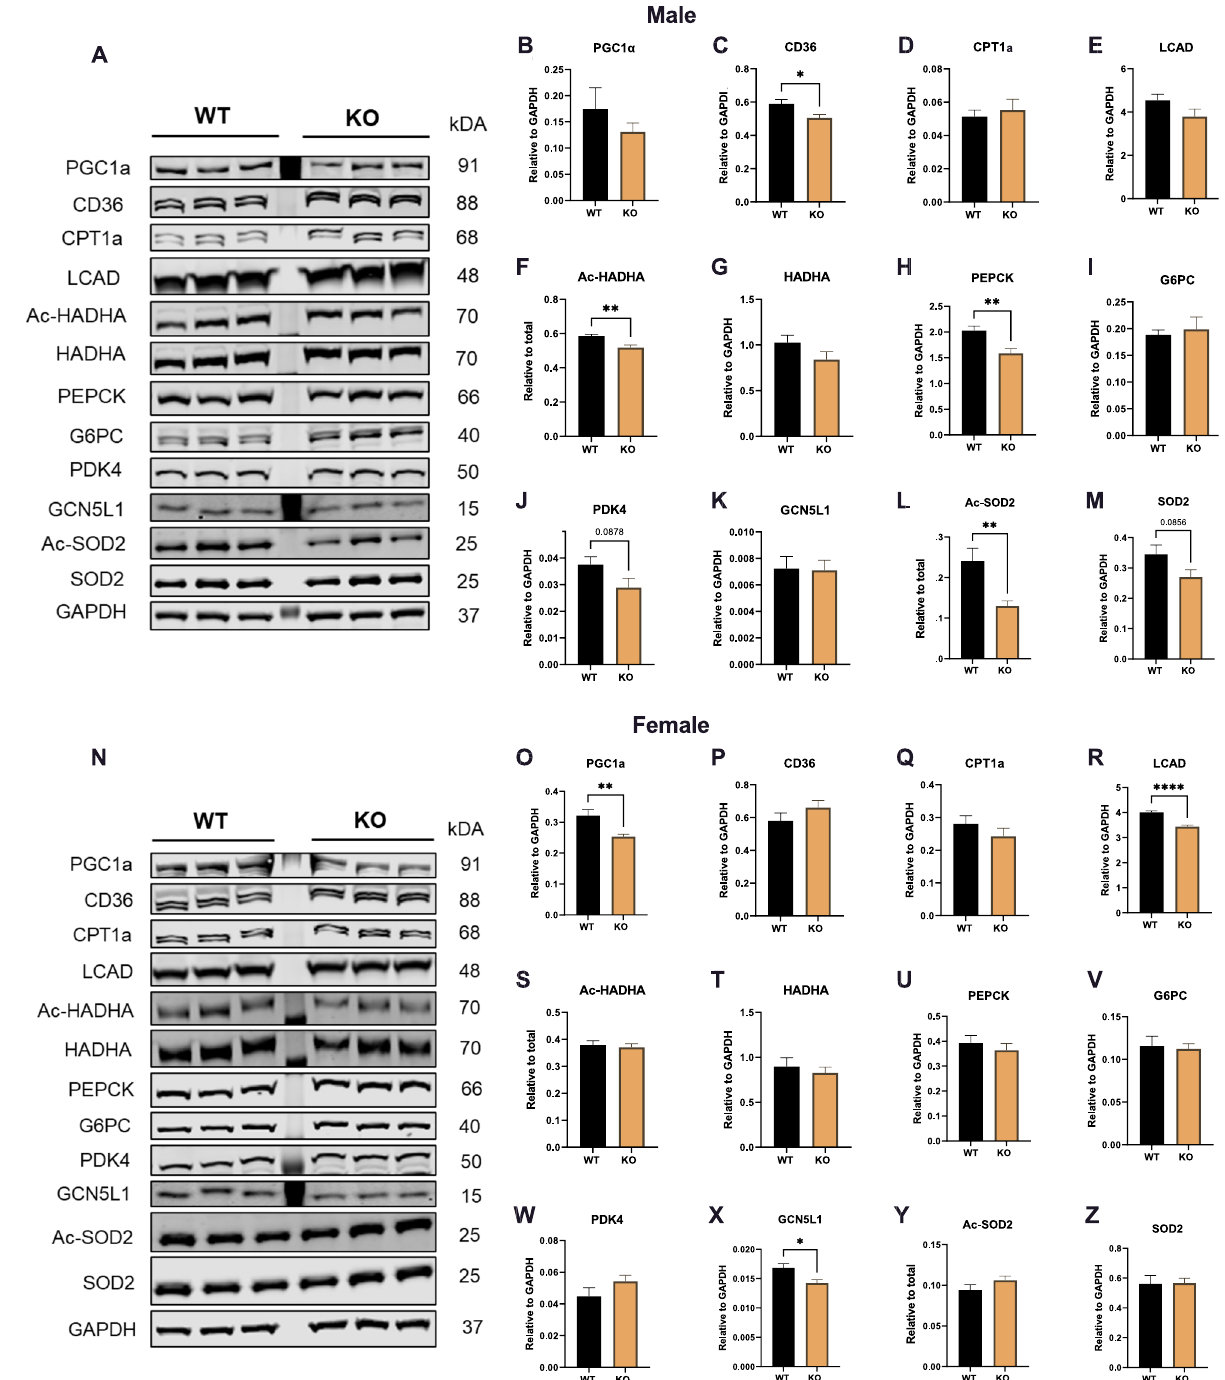
Figure 5. Loss of GPR19 is associated with changes in the protein abundance of lipid and glucose metabolic enzymes. After a 10-week HFD, male ( A–M ) and female ( N–Z ) wildtype or GPR19 KO mice were analyzed for the abundance of hepatic metabolism enzymes. * P < 0.05, ** P < 0.01, N =